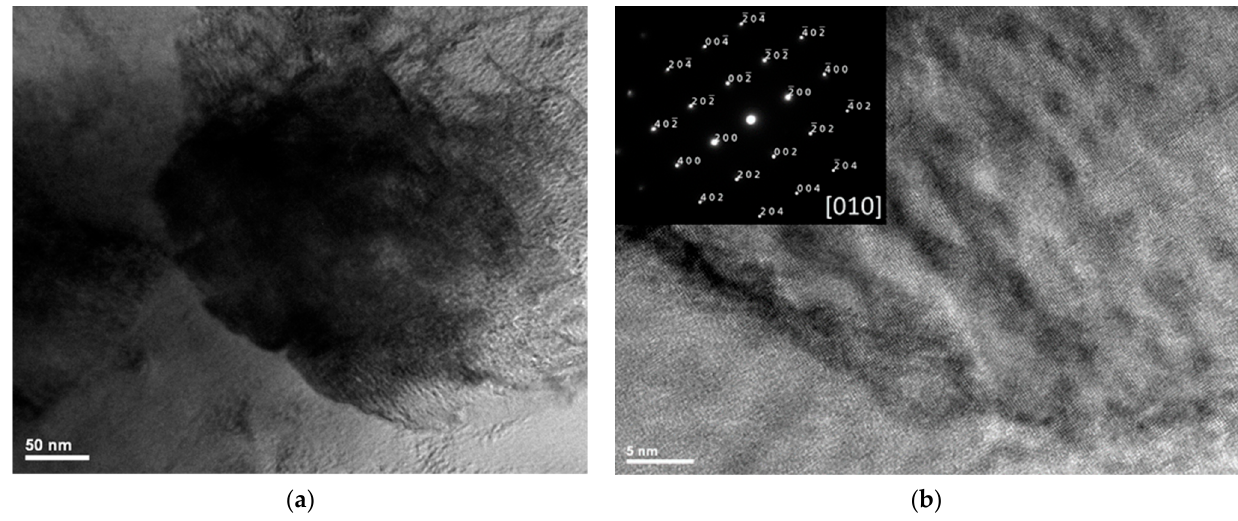
Figure 6. Bright field images of the structure of the free-standing Ti 1 − x Al x N layer in plan-view showing: ( a ) a large grain and ( b ) HRTEM and SAED image of a large fcc-Ti 1 − x Al x N crystal in higher resolution.